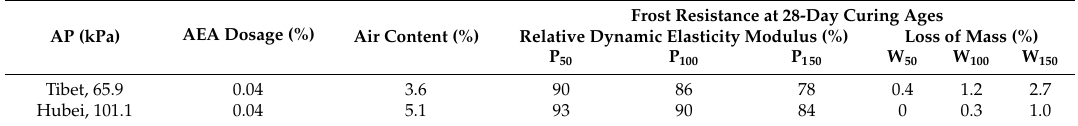
Table 10. Frost resistance of concrete formed under di ff erent AP. Frost Resistance at 28-Day Curing Ages AP (kPa) AEA Dosage (%) Air Content (%) Relative Dynamic Elasticity Modulus (%) Loss of Mass (%) P 50 P 100 P 150 W 50 W 100 W